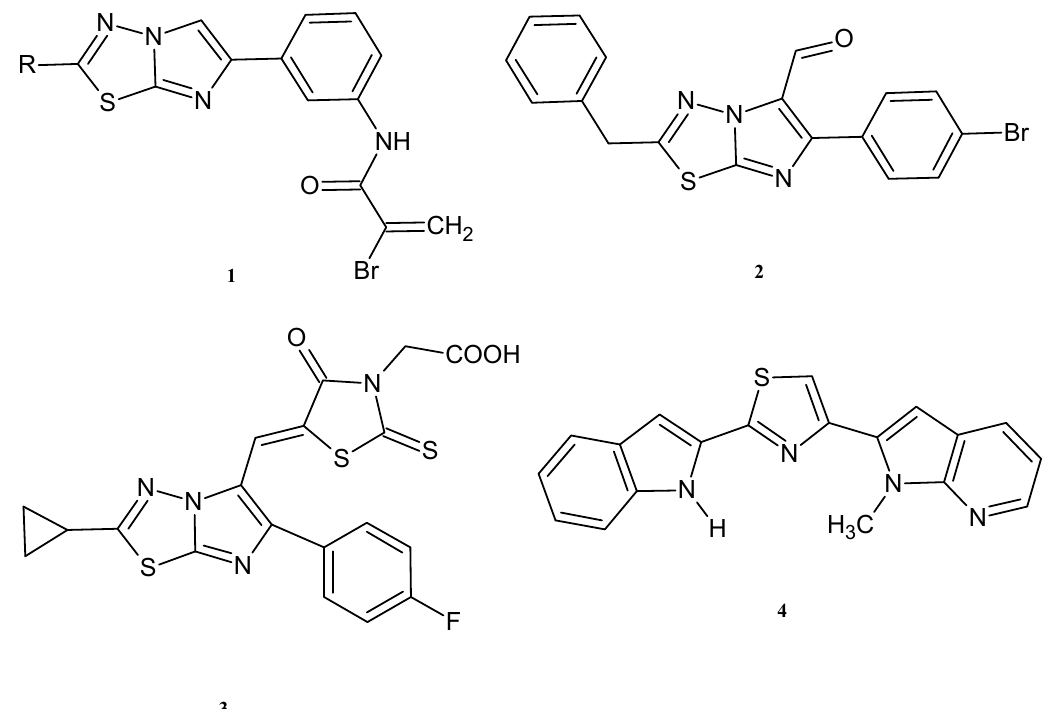
Figure 1. Chemical structures of the imidazo[2,1- b ][1,3,4]thiadiazole compounds 1 – 3 and of the indole derivative 4 .